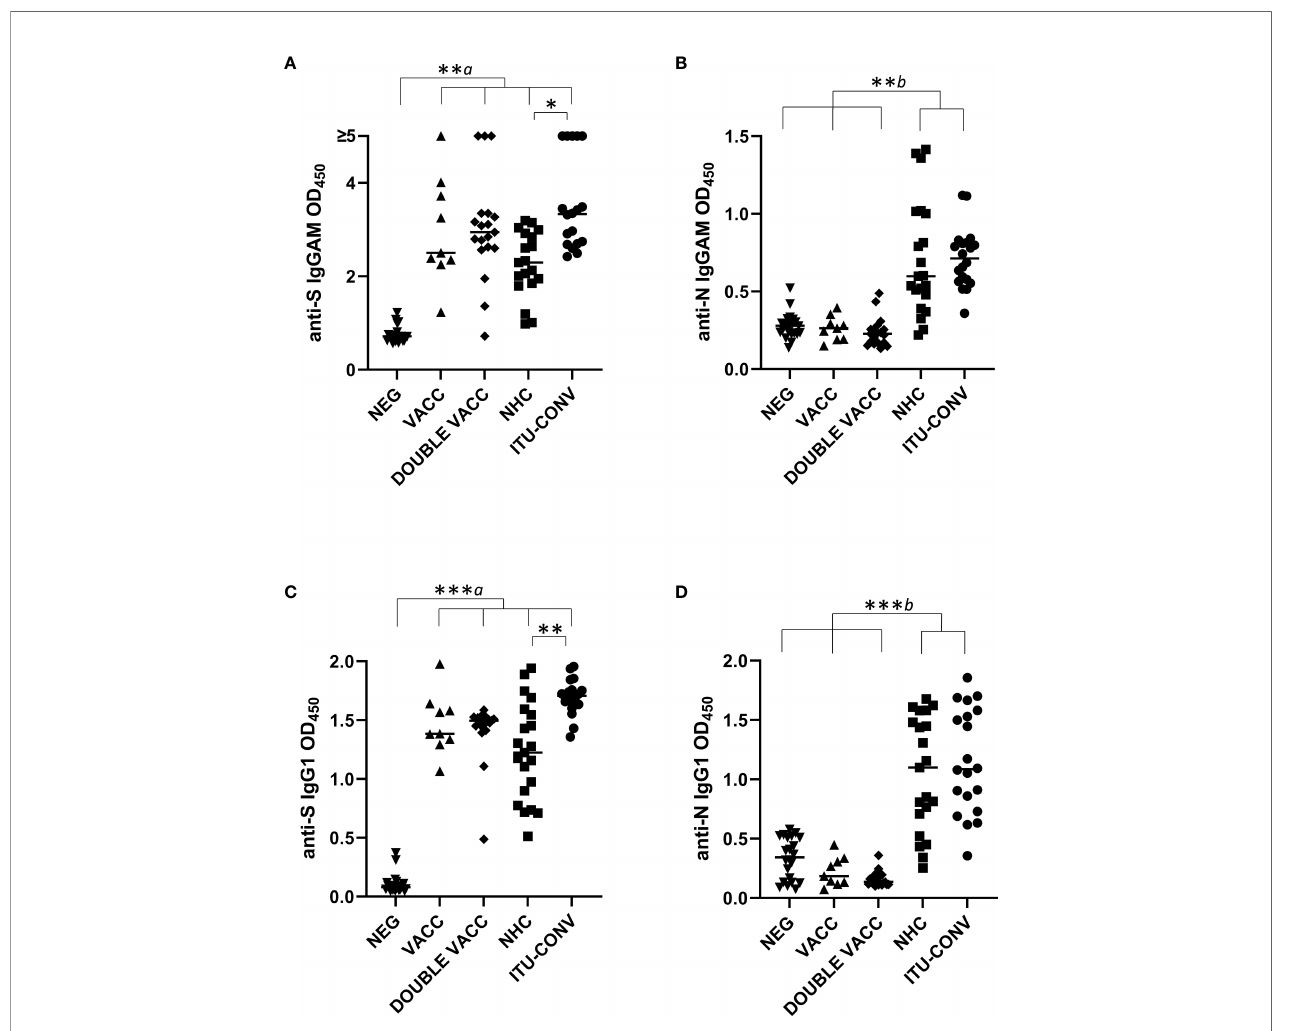
FIGURE 1 | Anti-S, but not anti-N antibody responses differ between NHC and ITU-CONV patients. Using an ELISA against 0.1ug S (A, C) or N (B, D) with HRP- conjugated IgGAM or IgG1 secondary antibodies, GAM and IgG1 levels were assessed in the following subject groups: COVID-19 negatives (NEG, n ≥ 20), COVID- 19 naïve one month post fi rst BNT162b2 vaccine (VACC, n = 9), COVID-19 naïve one month post second BNT162b2 vaccine (DOUBLE VACC, n = 19), COVID-19 positive non-hospitalised convalescents (NHC, n ≥ 19) and COVID-19 positive convalescents who required ITU treatment (ITU-CONV, n ≥ 18) Kruskal-Wallis with Dunn ’ s multiple comparisons test was used to test signi fi cance. a indicates that the four groups bracketed (VACC, DOUBLE VACC, NHC and ITU-CONV) were individually signi fi cantly different to the NEG group; b indicates that NHC and ITU-CONV are independently signi fi cantly different to NEG, VACC and DOUBLE VACC. ***p < 0.001, **p < 0.01, *p < 0.05. Bars represent median values for each